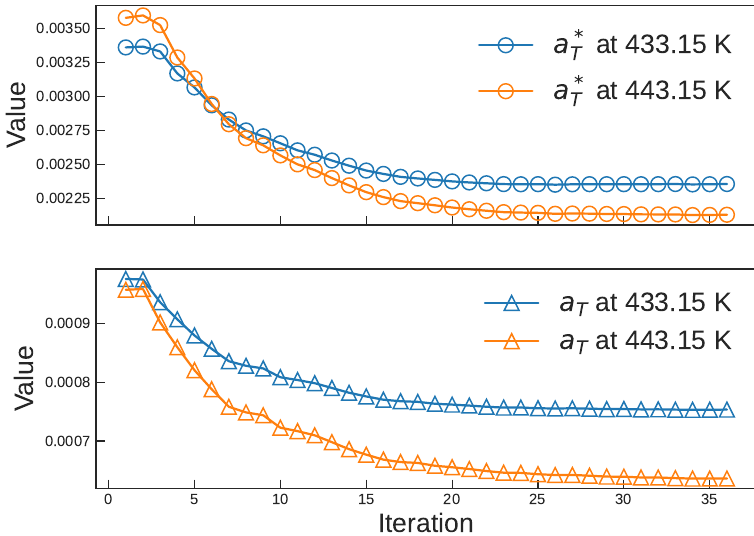
Figure 6. Evolution of the TTS shift factors (Scenario